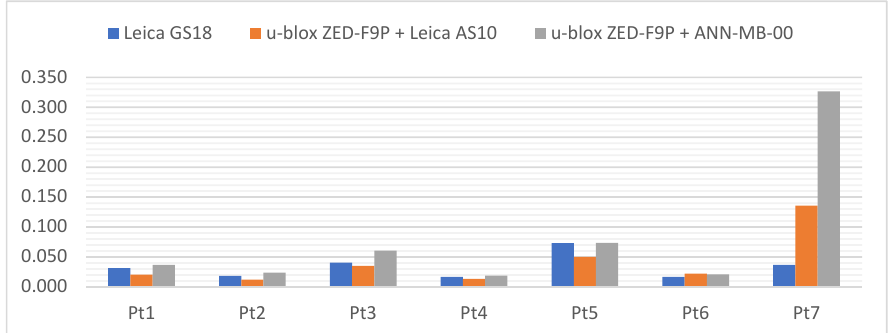
Figure 14. Sum of X, Y and H absolute differences [m] on each station point.